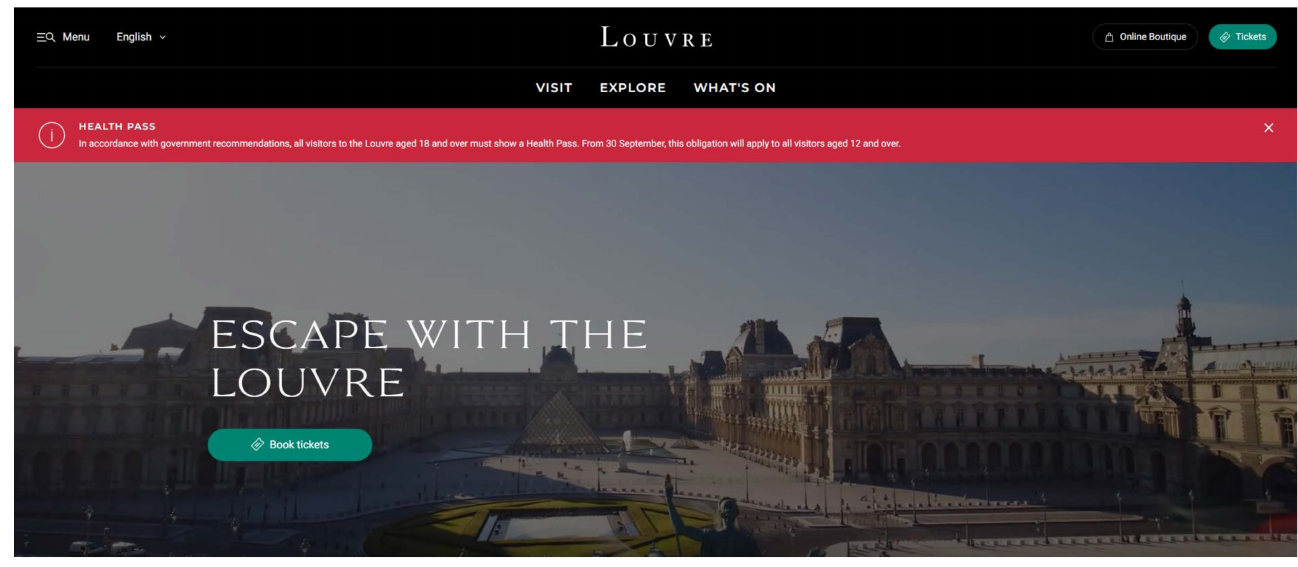
Figure 2. The website of the Louvre museum on 30 September 2021.